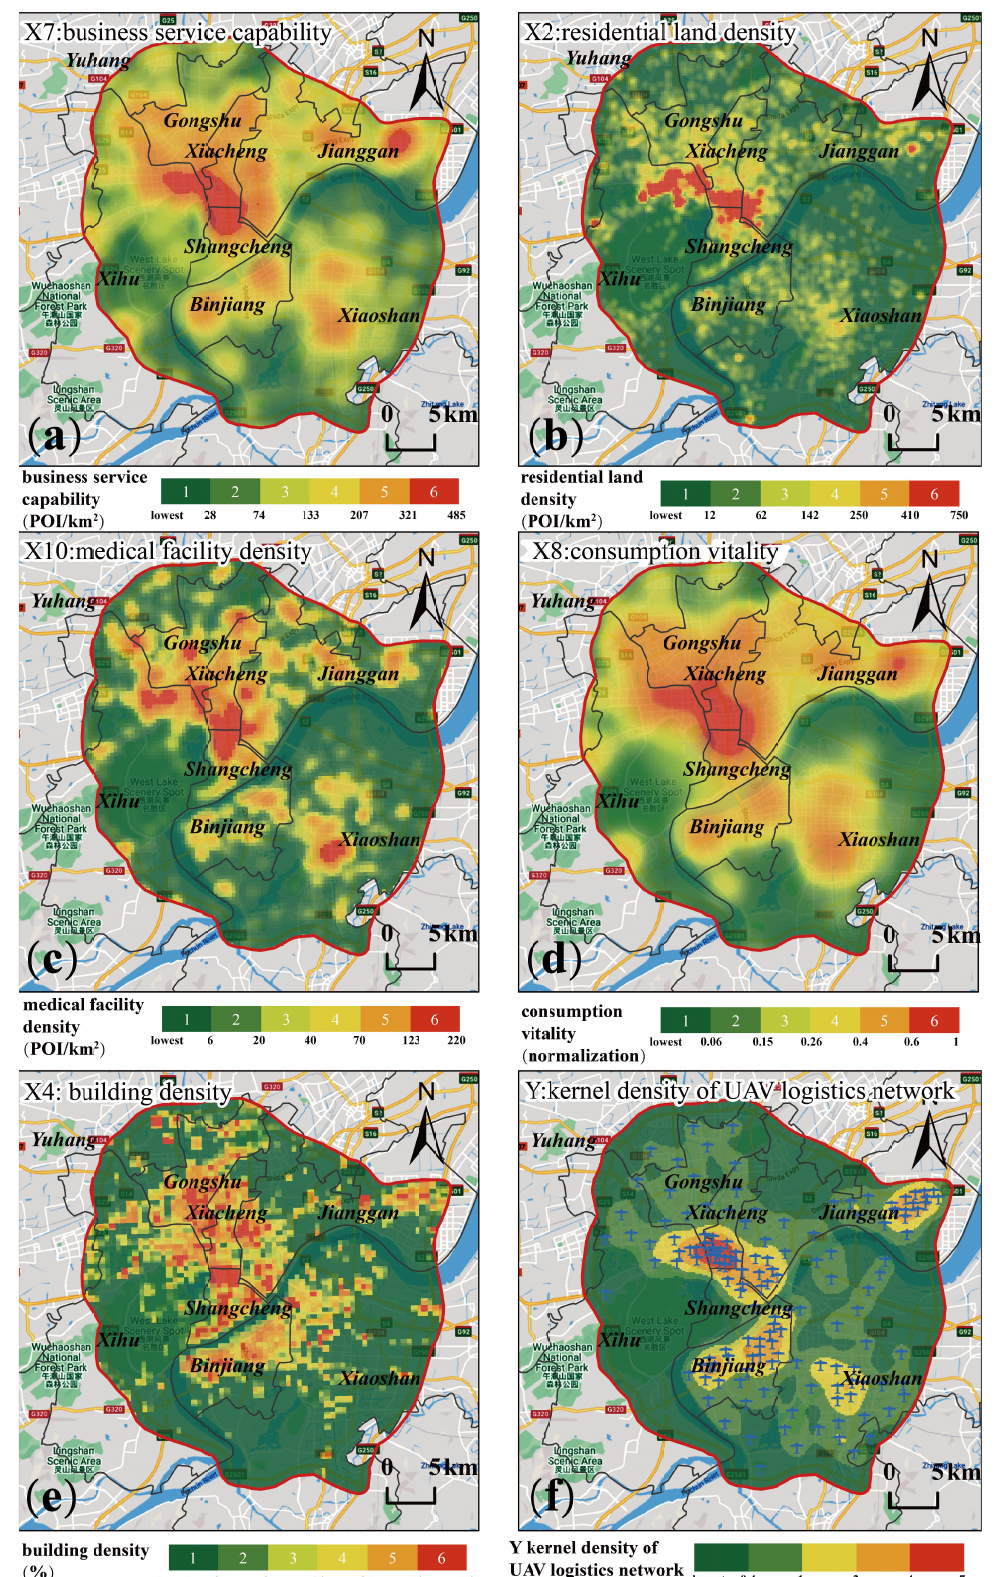
Figure 4. A spatial partition map of five leading impact factors and kernel density map of UAV logistics network in Hangzhou. ( a – e ) are the five leading impact factors in descending order of q-value, ( f ) represents the spatial density of logistics